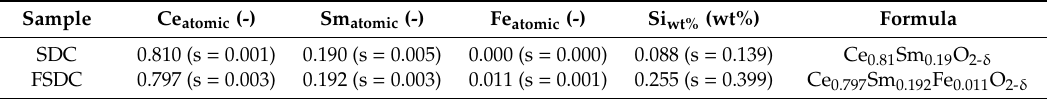
Table 1. SDC and FSDC powder composition by ICP-OES.